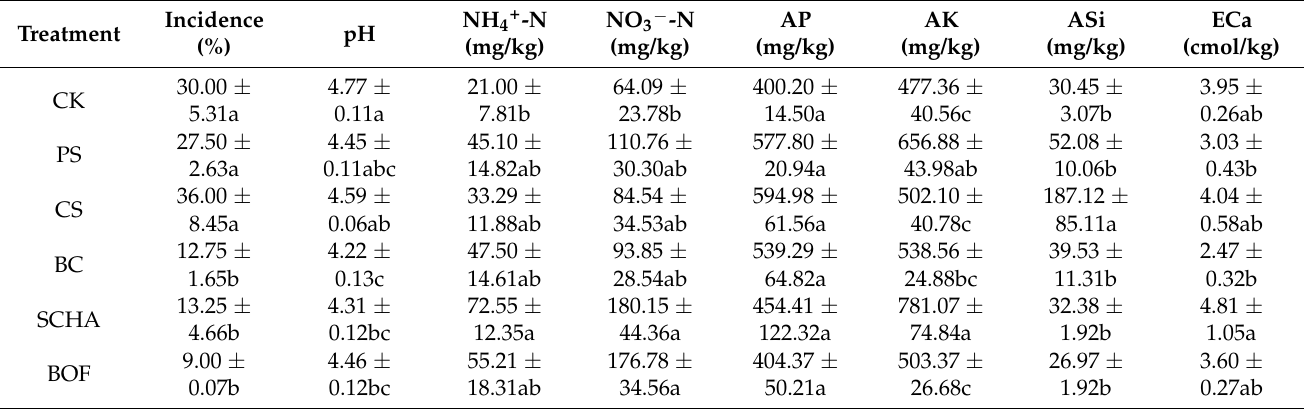
Table 2. The variance analysis of disease incidence and the soil physical and chemical properties in different treatments at 62 days after